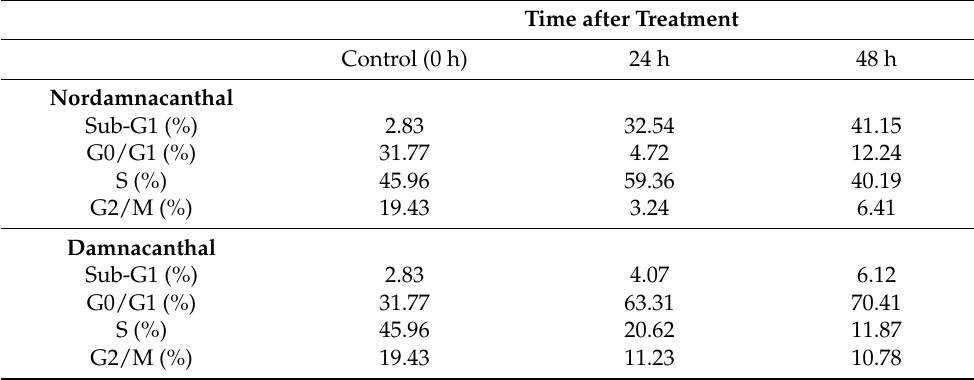
Figure 16. Cell cycle distribution of CEM-SS cells after 24 h and 48 h incubation with ( A ) nordamnacanthal and ( B ) damnacanthal at their respective IC 50 values. Table 1. Summary of cell cycle distribution of CEM-SS cells after 24 h and 48 h incubation with nordamnacanthal and damnacanthal at their respective IC 50 values.